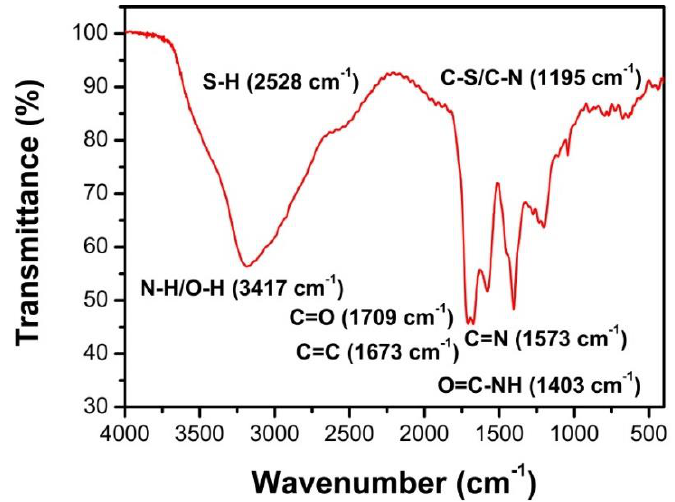
Figure 6. FTIR spectra of as-synthesized N, S-GQDs.